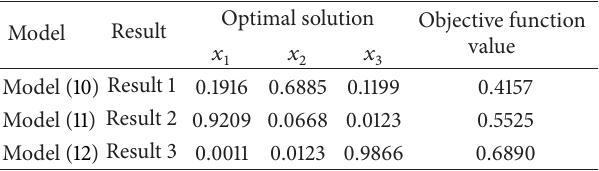
Table 2: The results of models